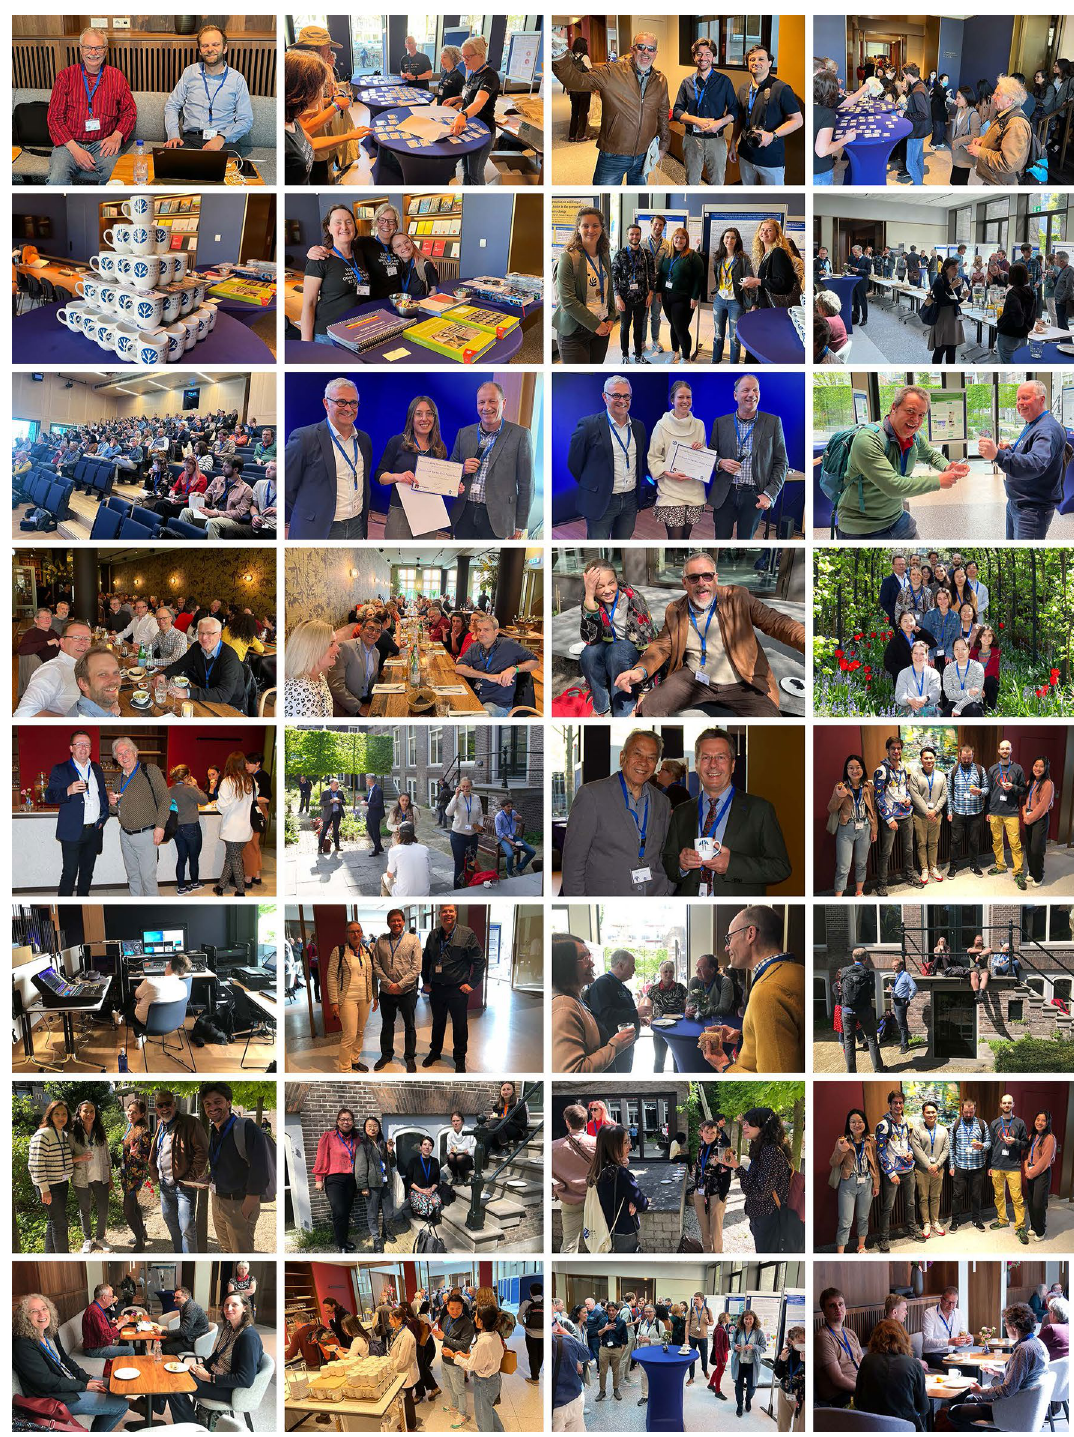
Fig. 12 Rise of the fungi 2022 participants interacting outside the